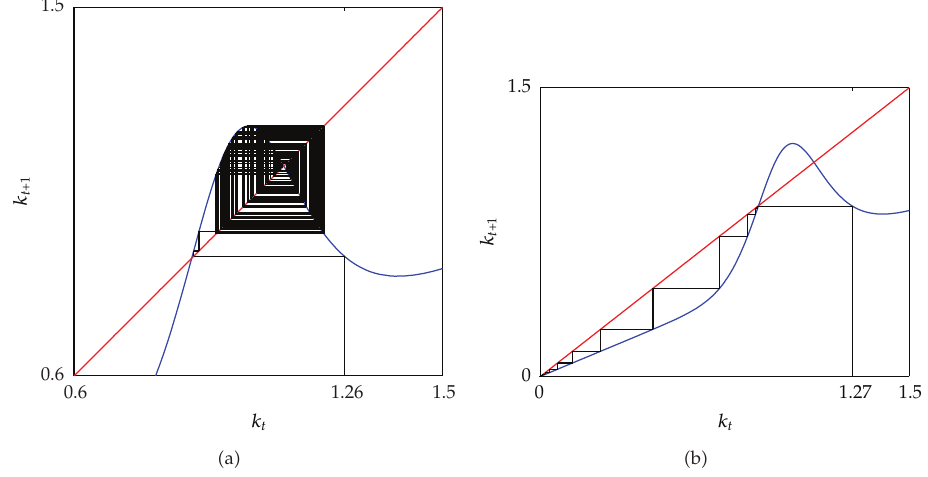
Figure 7: K-L staircase diagram for the following parameter values: δ (cid:7) 0 . 2, α (cid:7) 0 . 4, β (cid:7) 0 . 9, n (cid:7) 0 . 5, s w (cid:7) 0 . 1, s r (cid:7) 0 . 9, and p (cid:7) 11. (cid:3) a (cid:6) k 0 (cid:7) 1 . 26 generates a trajectory converging to A consisting in a complex set; (cid:3) b (cid:6) k 0 (cid:7) 1 . 27 generates a trajectory converging to A 0